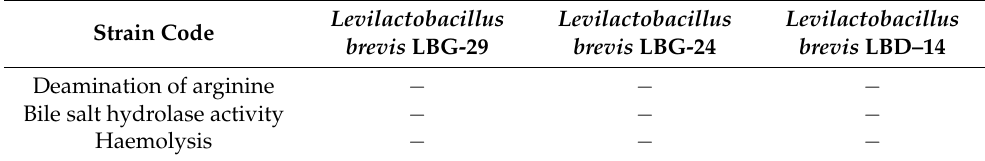
Table 4. In vitro safety evaluations of the three Levilactobacillus brevis strains. Strain Code